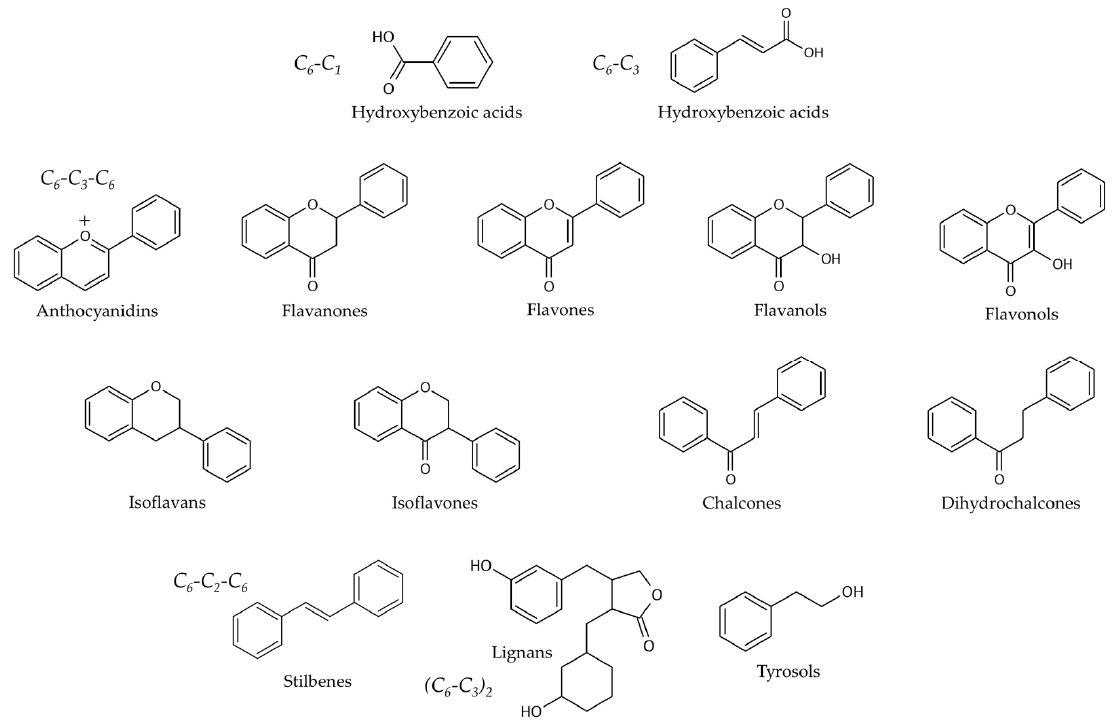
Figure 1. Basic chemical structures of main categories of polyphenols.